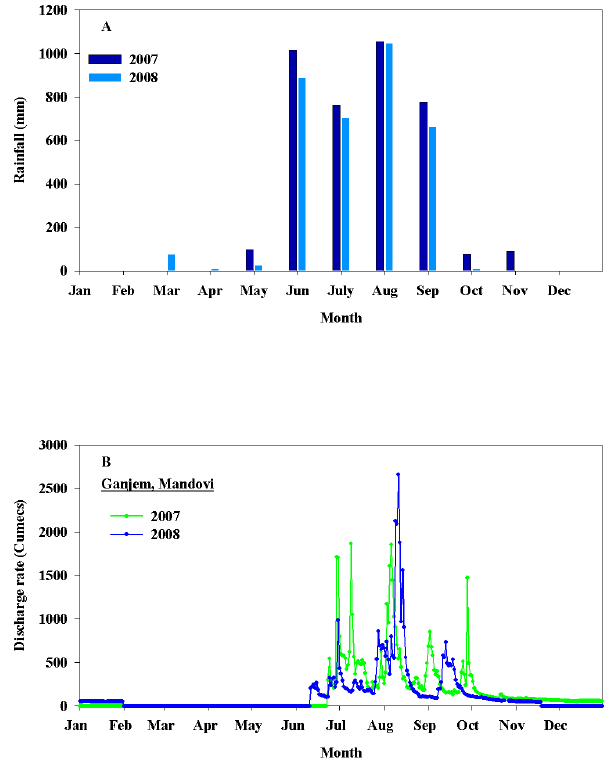
Fig. 6. (A) Monthly arithmetic average of rainfall in mm at Goa for the year 2007 and 2008; (B) Freshwater discharge rate at Ganjem, Mandovi estuary in cumecs or m 3 s − 1 for the year 2007 and